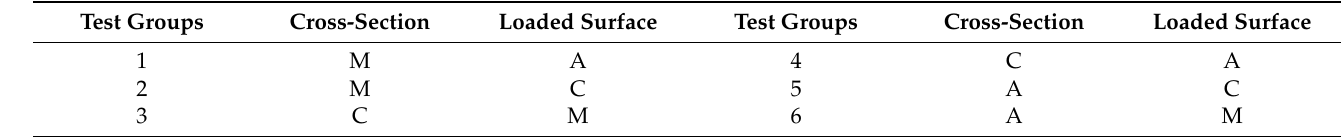
Table 3. Testing